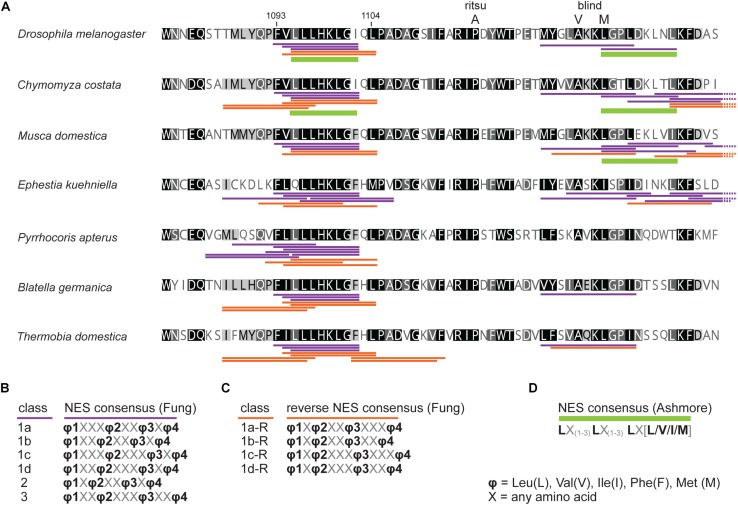
In silico prediction of nuclear export signals (NESs) in TIMrit vicinity. (A) Protein alignment (ancestral species are at the bottom) with underlined NES motifs. Purple and orange colors code for forward and reverse NES classes, respectively, and green bar indicates strict NES prediction after Ashmore et al. (2003). (B–D) The consensus sequences of NES classes. Numbers above the alignment correspond to amino acid residues in L-TIM (D. melanogaster).